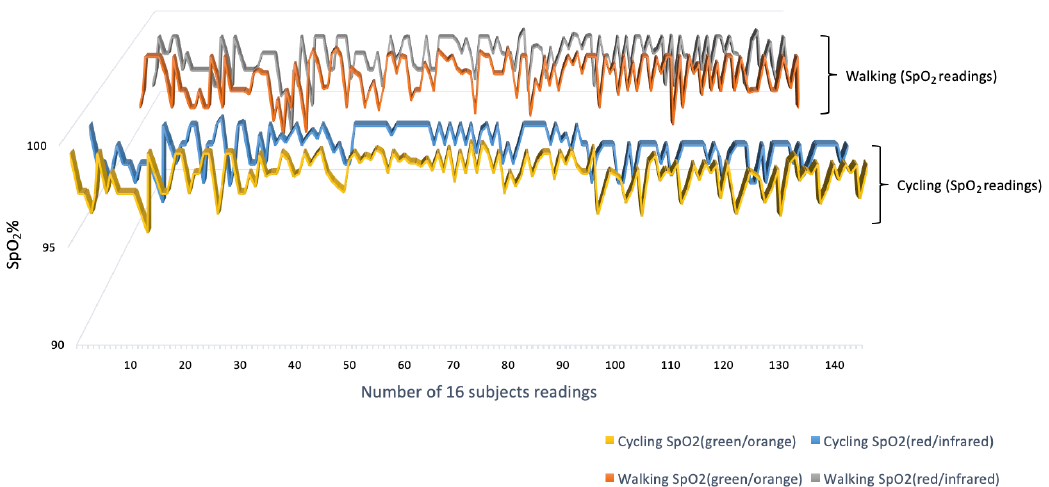
Figure 9. SpO 2 data obtained from the mOEPS (green/orange) and the mOEPS (red/infrared) for different exercises.